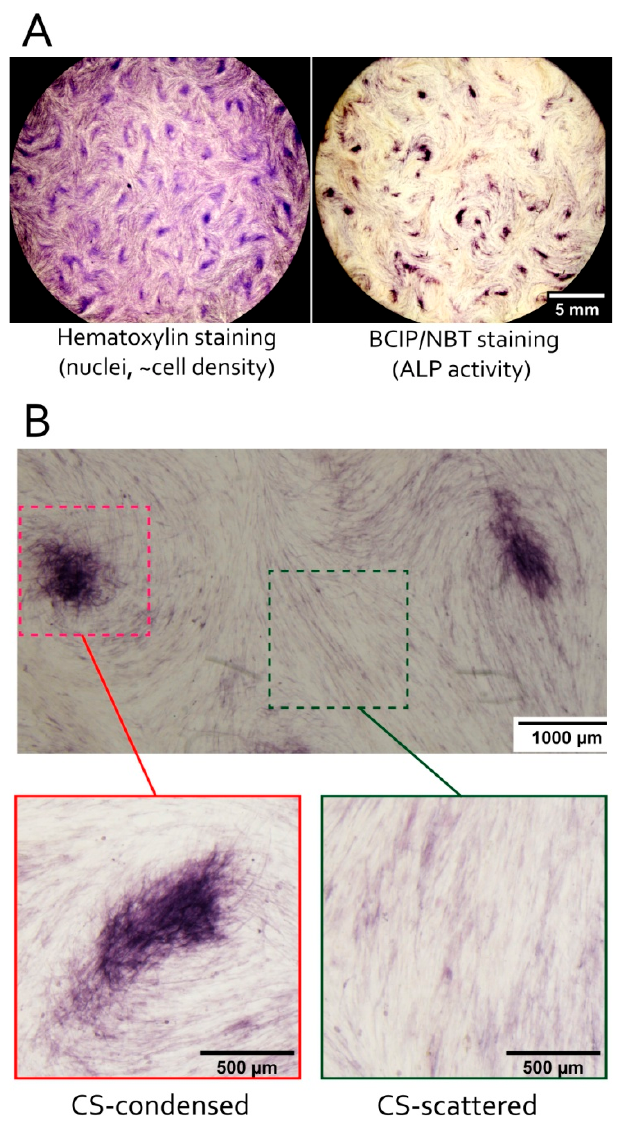
Figure 4. The local activity of alkaline phosphatase (ALP) spontaneously increases in MSC within condensed areas of the cell sheet (CS). ( A ) MSC sheets stained by hematoxylin to visualize the cell density (left) or by BCIP/NBT chromogenic substrates to visualize the ALP activity (right). We present an image of a CS cultured in parallel with one subject to ALP visualization; light microscopy (brightfield); scale bar 5 mm. ( B ). Representative images of condensed areas with obvious ALP activity visualized after treatment by specific chromogenic substrates; light microscopy (brightfield); magnification 40× (upper image) and 80× (lower row of images).